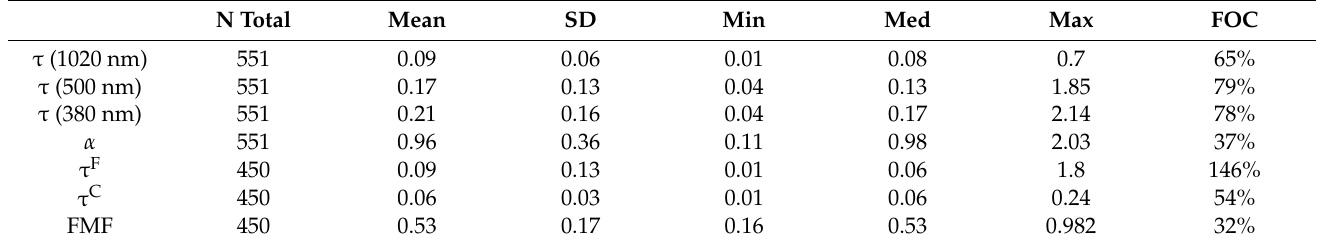
Table 2. Multi-wavelength (1020, 500 and 380 nm) aerosol optical depth τ , Ångström exponent ( α (440–870)), fine aerosol optical depths at 500 nm ( τ F (500 nm), coarse aerosol optical depths at τ C (500 nm)) and fraction of optical depth of fine mode particles (FMF) in Taiping from 1 January 2018 to 31 December 2020; All data were processed using daily averages. The total number of samples (N total), average coefficient (Mean), standard deviation (SD), Minimum (Min), Median (Med), Maximum (Max) and the coefficient of fluctuation (FOC) are also counted to assess variations in the